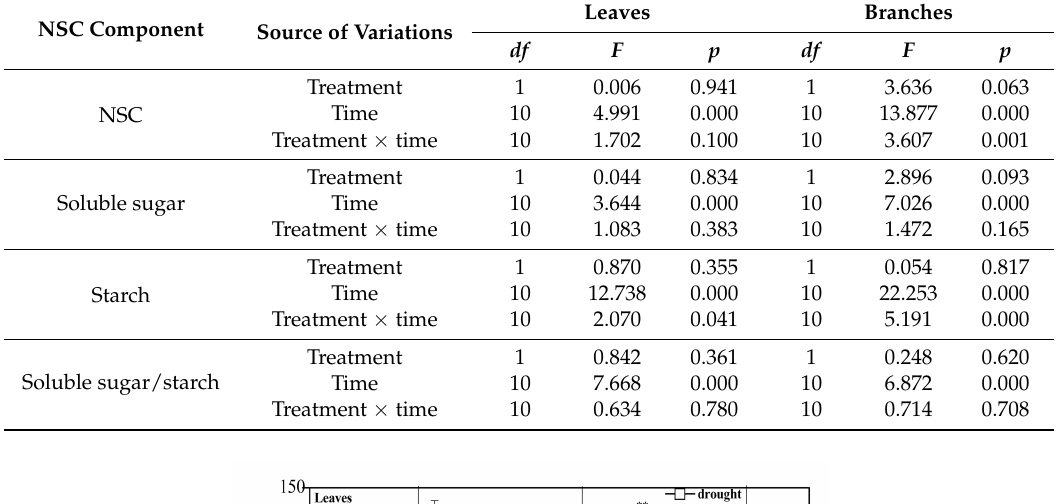
Table 1. Repeated measures analysis of variance (ANOVA) of nonstructural carbohydrate (NSC) concentration and composition by treatment and sampling date.